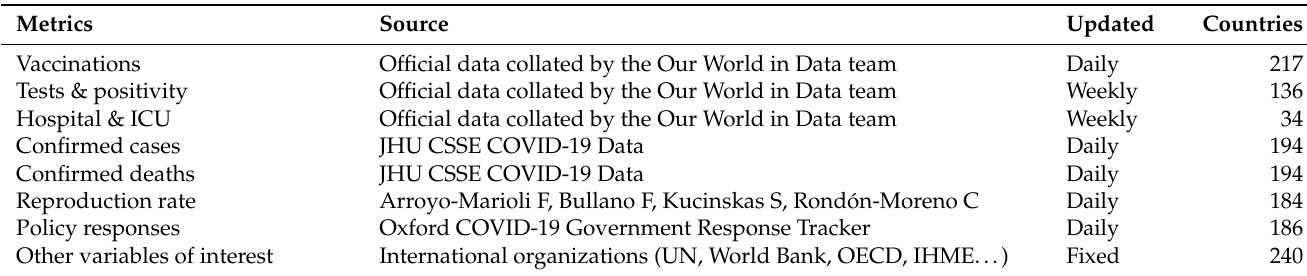
Table 2. OWID COVID-19 Dataset Summary.